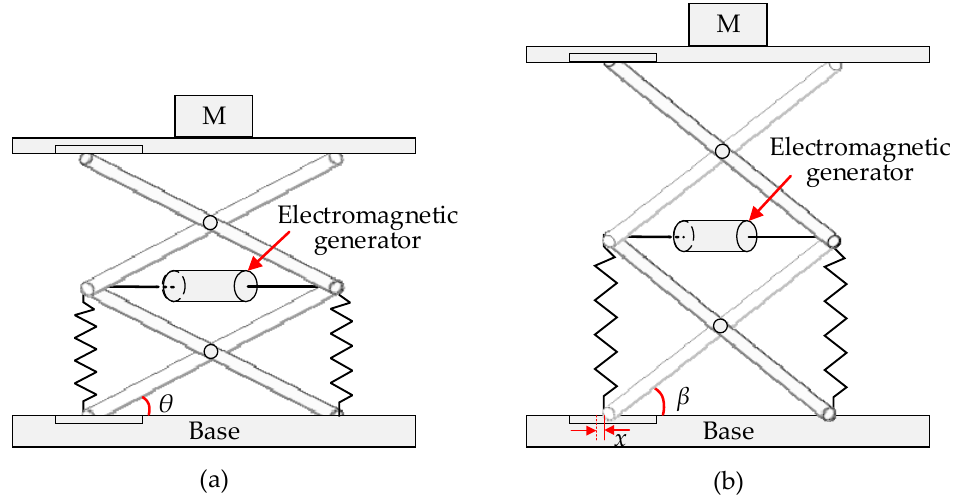
Figure 18. Schematic diagram of the designed nonlinear energy harvesting system: ( a ) State 1; ( b ) State 2.